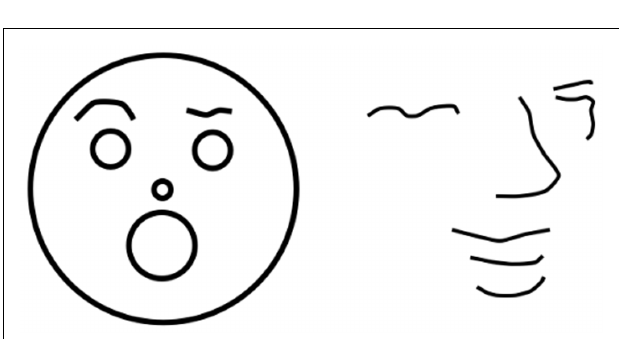
FIGURE 5 | Junctions trigger local interpretations. TheT-junctions along the edge at the base of the middle cube imply that this is the edge of an opaque surface that hides the bottom of the cube. However, the same edge then makes X-junctions with the contours of the outer cubes, indicating that it is a cord with no opaque surface on either side.These junctions drive local interpretations that do not require consistency across larger distances to be perceived (from Kennedy, 1974).